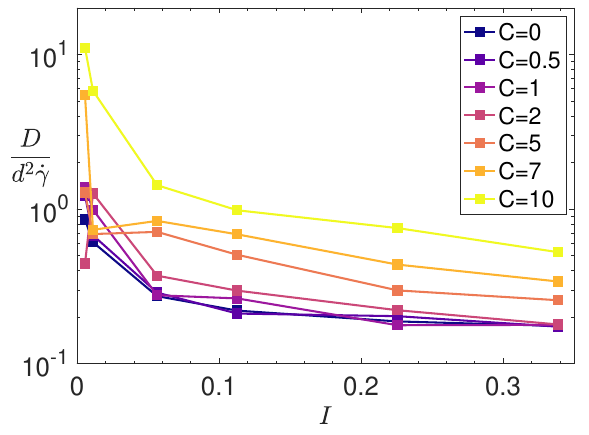
Figure 2. Di ff usivity D measured using (6) in flows with di ff er- ent inertial numbers I and cohesion number C .